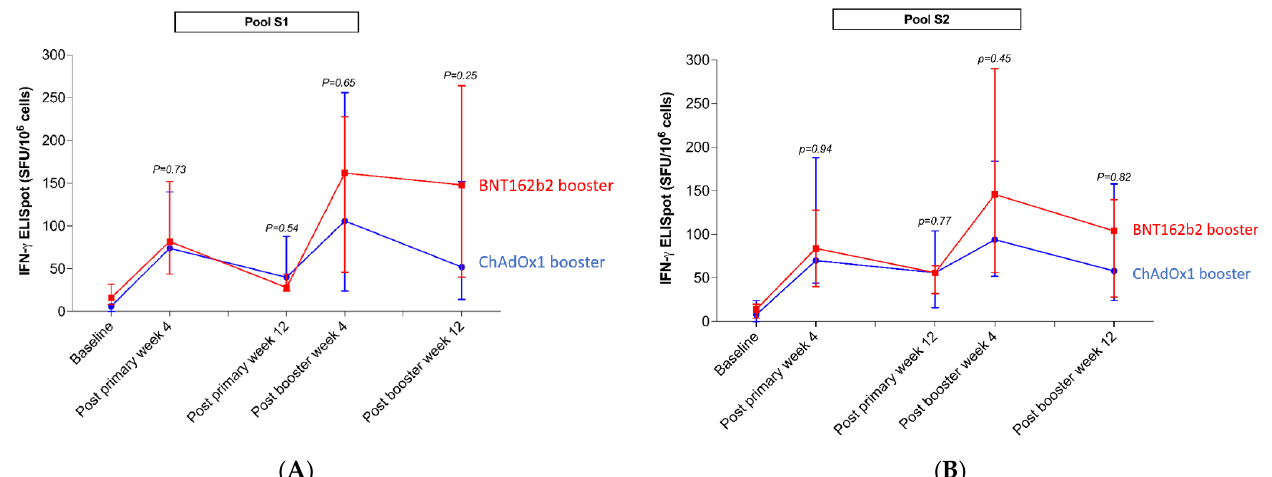
Figure 3. Dynamics of T-cell response by ELISpot ( A ) Pool S1, and ( B ) Pool S2 in participants who received primary CoronaVac vaccination and were boosted with BNT162b2 or ChAdOx1 .